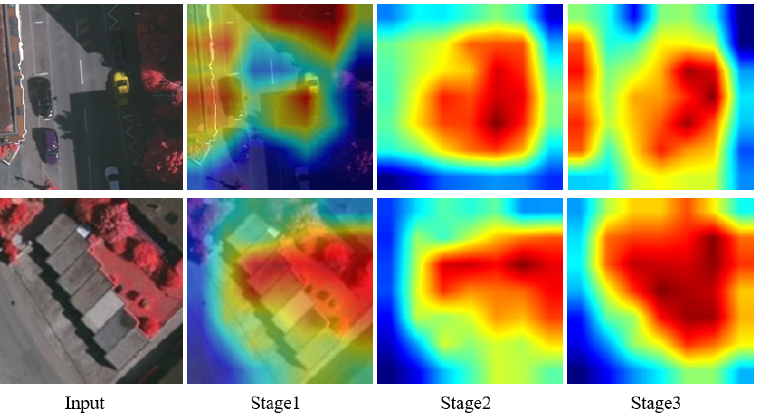
Figure 13. Heat map of small target objects in different stages.